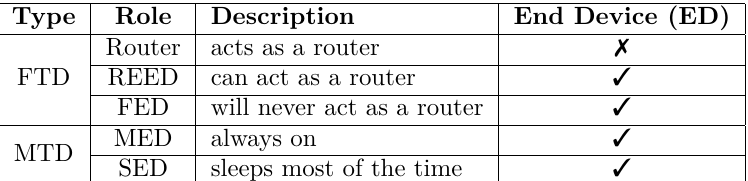
Table 1: Device types and roles in a Thread